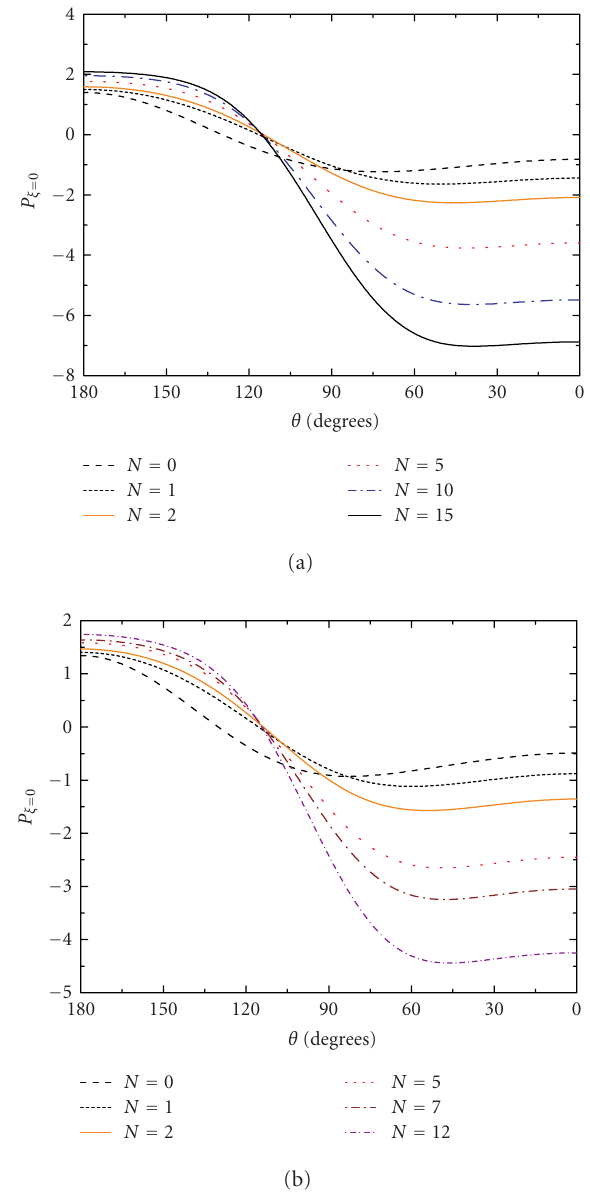
Figure 4.7 . Angular evolution of surface pressure for (a) Re = 10 and (b) Re = 20. experimental results of Josserand et al. [8]. From the plots of angular evolution of sur- face pressure, it is observed that in comparison with the case of no magnetic field,